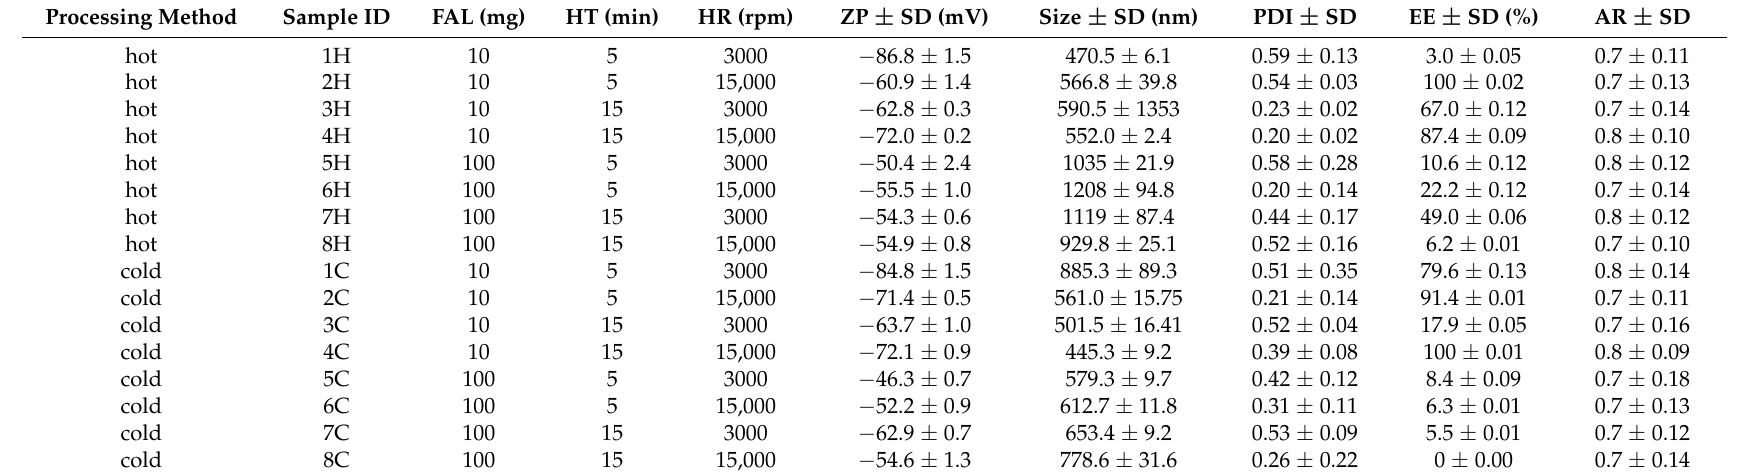
Table 1. Physicochemical properties of ethosomes obtained using different processing